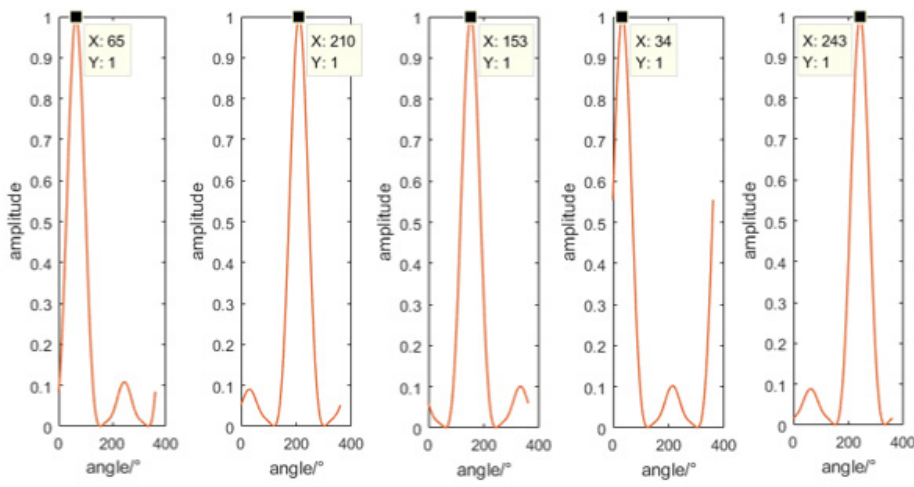
Figure 15. Time domain diagram of pulse signal.